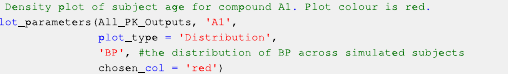
3.3.6.3 Distribution plots Code Block 17. Function to create a distribution